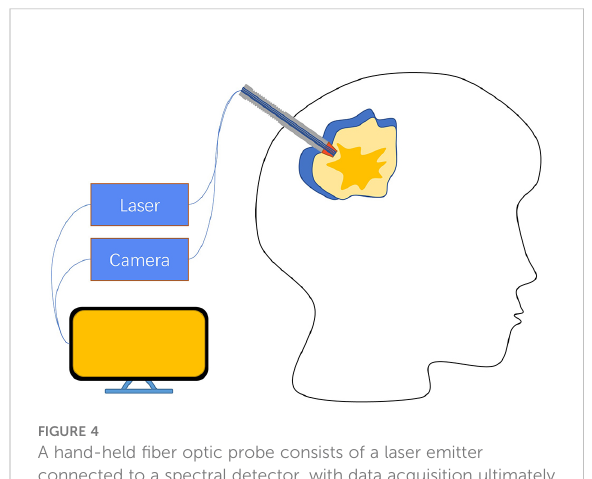
FIGURE 4 A hand-held fi ber optic probe consists of a laser emitter connected to a spectral detector, with data acquisition ultimately controlled by a PC. The illumination and detection light paths are spatially coincident. When the probe performs measurements, it is in direct contact with the brain at the resection edge